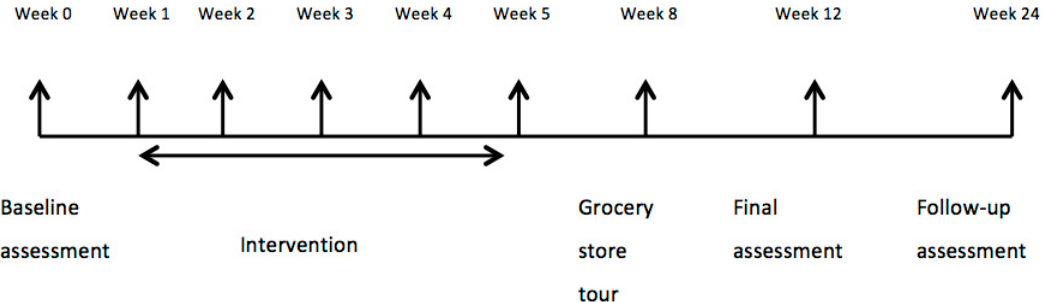
Figure 2. Intervention timeline.